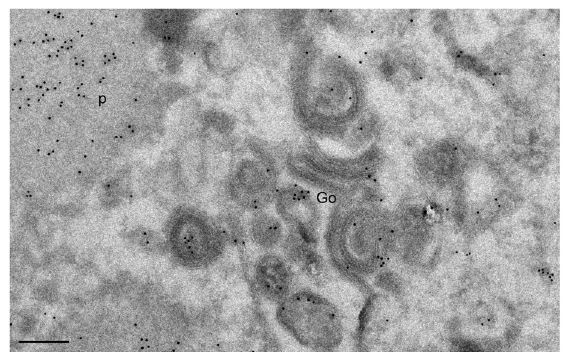
Figure 5. Golgi membranes 20 hpi with CK177 Δ Us3gK-HA after immunogoldlabeling using antibodies against HA. Gold particles are irregularly distributed on electron dense Golgi membranes (Go) as well as on proteinaceous deposits (p). Bars, 200